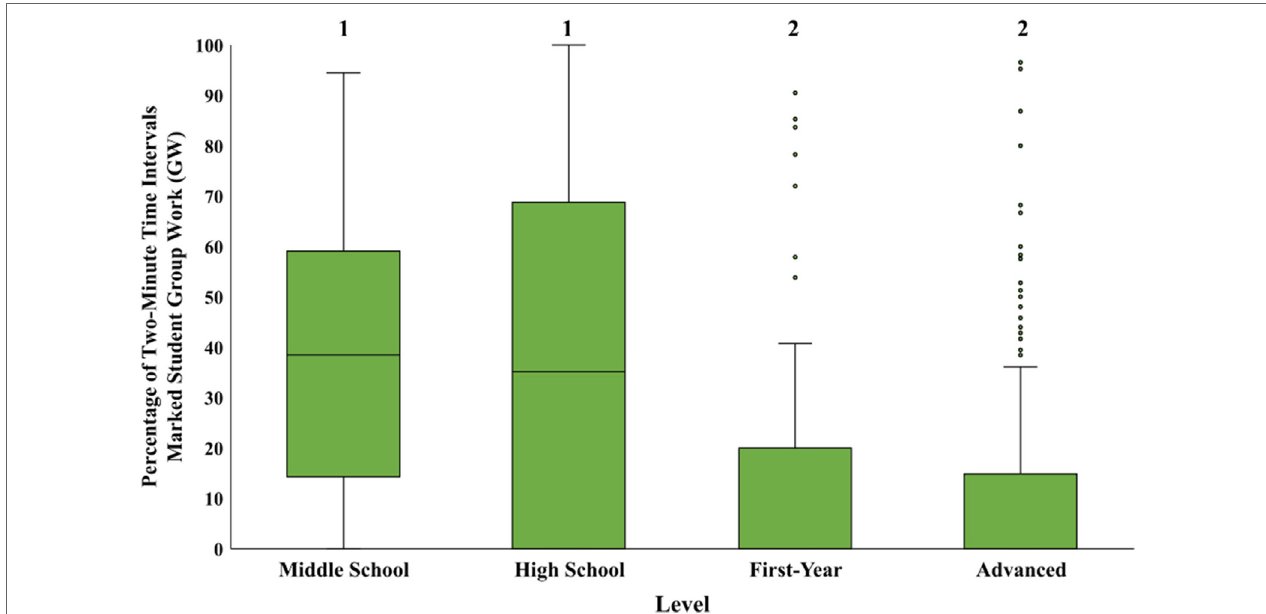
FigUre 8 | Comparison of the relative frequency of Classroom Observation Protocol for Undergraduate STEM code Student Group Work (GW) for middle school, high school, first-year university, and advanced university classes. Box-and-whisker plots showing the median and variation between the four instructional levels. The line in the middle of the box represents the median percentage of 2-min time intervals for the class sessions in each level. Boxes represent the interquartile range, whiskers represent 1.5 times the interquartile range, and data points not included in 1.5 times the interquartile range are shown with dots. Levels labeled with different numbers indicate a significant difference in mean ranks by a post hoc Dunn’s pairwise comparison (Kruskal–Wallis Test, χ 2 = 81.60, df = 3, N = 482, p < 0.001; Dunn’s pairwise comparisons, p < 0.001 for levels labeled with different